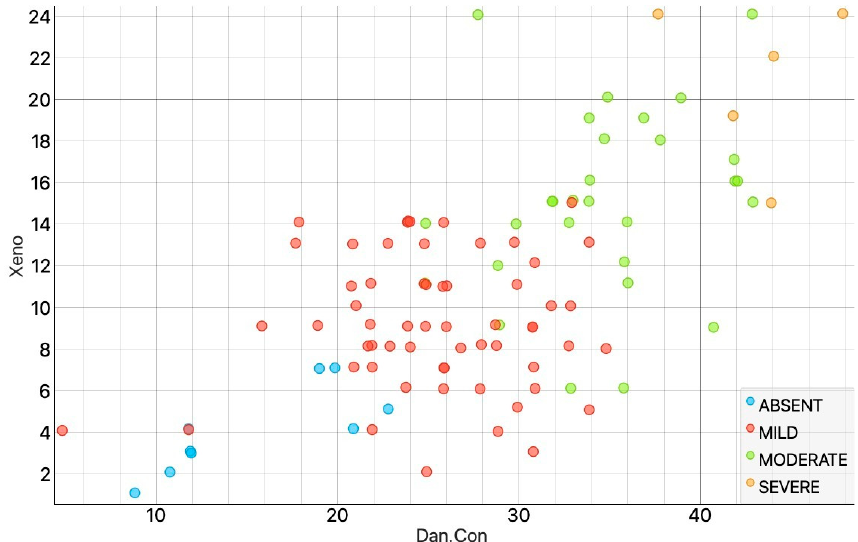
Figure 3. Stress level distribution in healthcare personnel from the intersection of xenophobia and danger + fear of contamination scales from the ACSS.